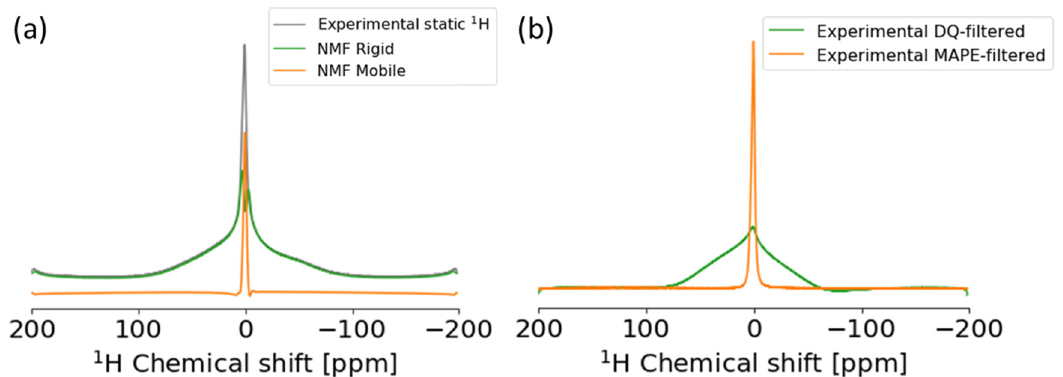
Figure 3. Application of non-negative matrix factorization (NMF) to static 1 H solid-state NMR of poly- ε -caprolactone (PCL). ( a ) Experimental anisotropic spectrum (gray) and spectra of rigid (green) and mobile (orange) components separated by NMF. ( b ) Experimental spectra of double-quantum (DQ) filtered ssNMR (green) and magic-and-polarization echo (MAPE) filtered ssNMR (orange).